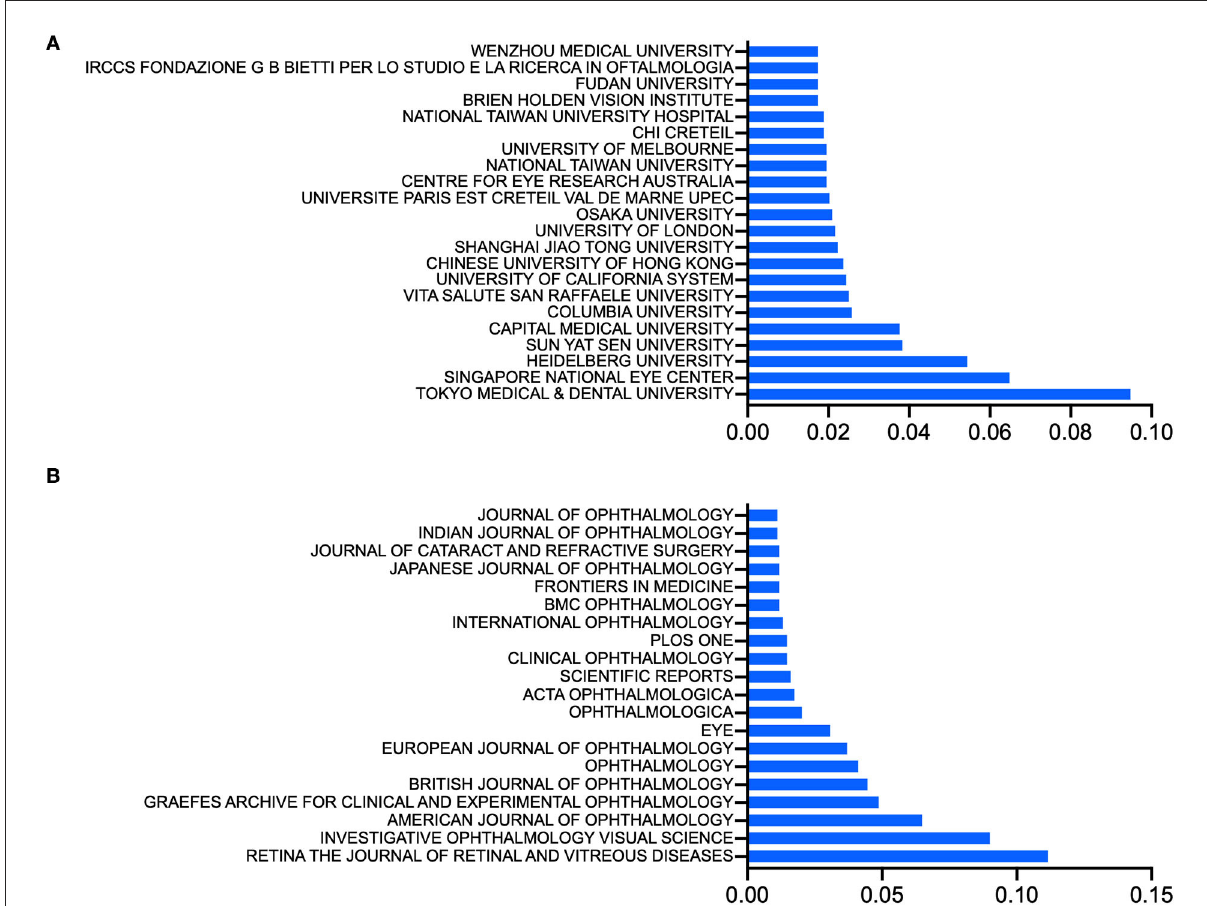
FIGURE3 (A) Top institutions, ranked by the ratio of the number of publications from an institution to the total number of included publications about pathologic myopia. (B) Top journals, ranked by the ratio of the number of publications from a journal to the total number of included publications about pathologic